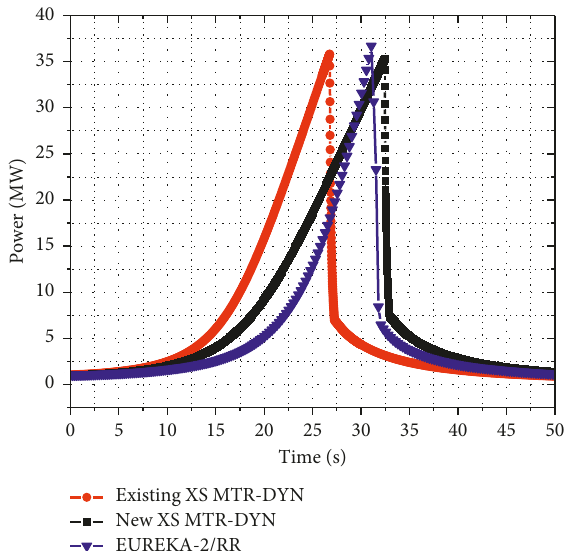
Figure 14: Reactor power response for RIA transient analysis within power range.